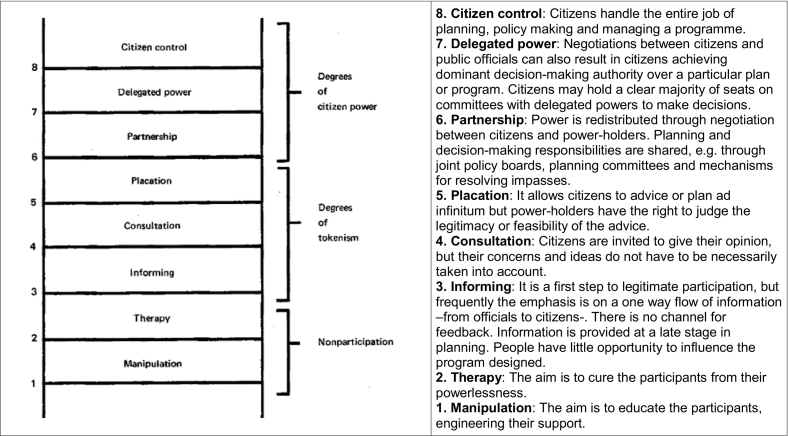
Eight rungs on a ladder of stakeholder and citizen participation. Source: Arnstein (1969).